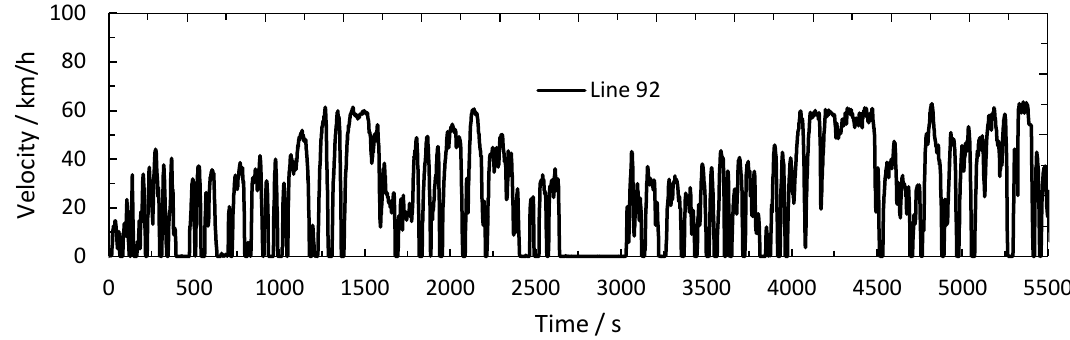
Figure 2. Velocity profile of bus line 84 in Stuttgart, Germany.